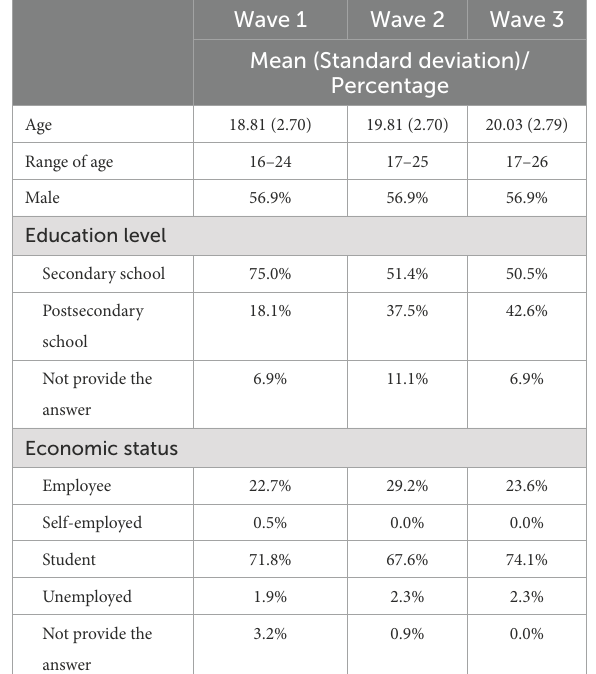
TABLE 1 Descriptive statistics for participants in three waves ( N =